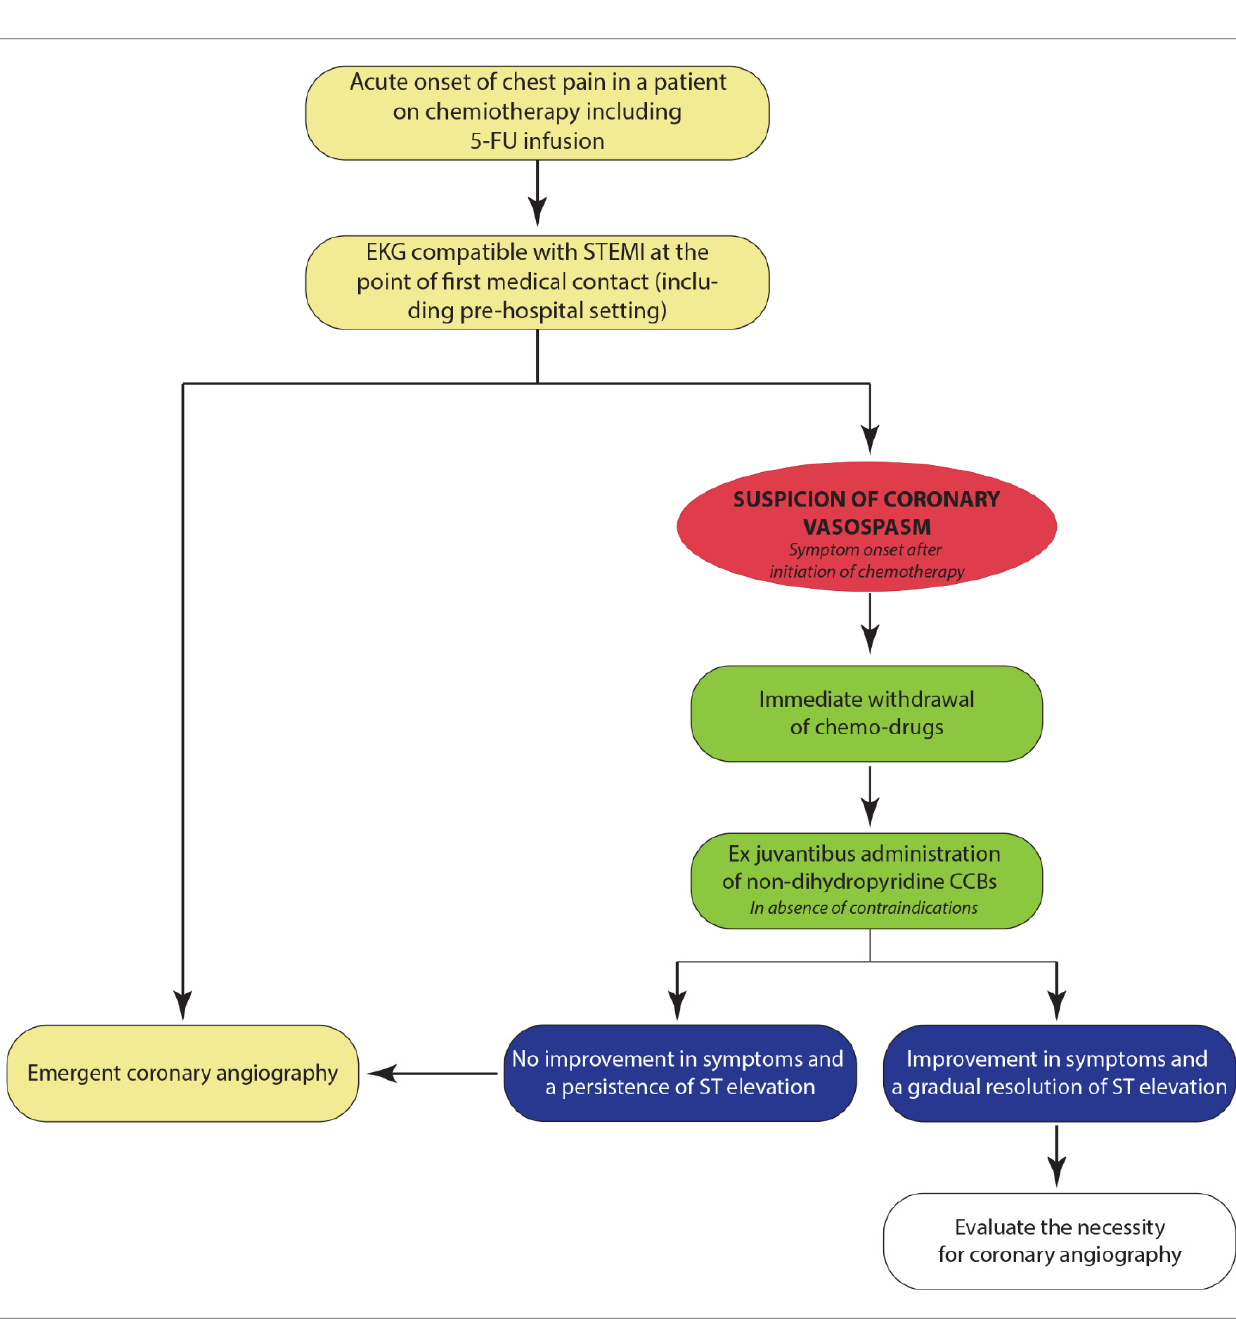
Figure 7. Diagnostic − therapeutic pathway of STEMI in patients undergoing 5-FU infusion.